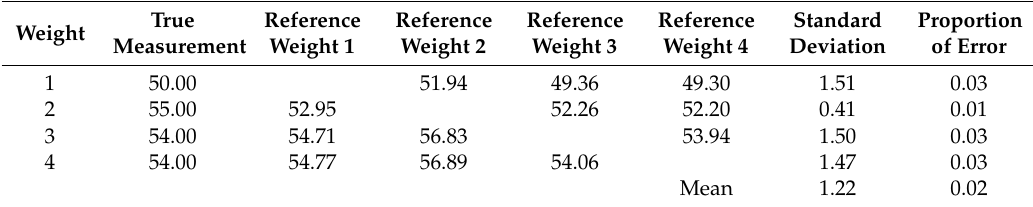
Table 1. Measurement matrix (in mm), standard deviation, and proportion of error of reference weight measurements used in this study.